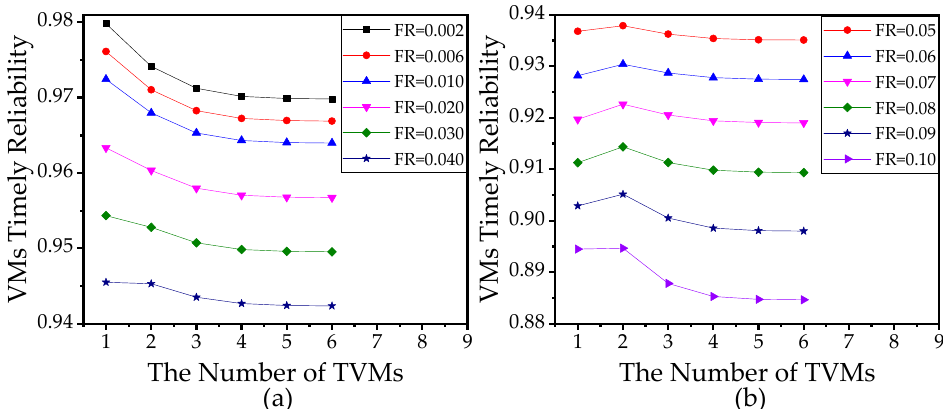
Figure 15. ( a ) VTR versus the number of task VMs (TVMs) where the total number of VMs is 10 and the failure rate (FR) ranges from 0.002 to 0.04. ( b ) VTR versus the number of TVMs where the total number of VMs is 10 and the FR ranges from 0.05 to 0.1. In ( a , b ), the number of sensors is 10. The other parameters used in ( a , b ) refer to Table 3.